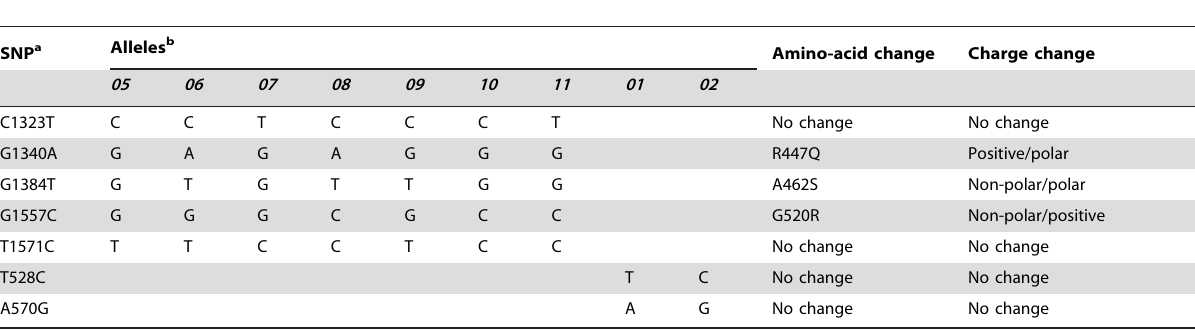
Table 1. SNPs and alleles identified in ovine TLR9 and MyD88